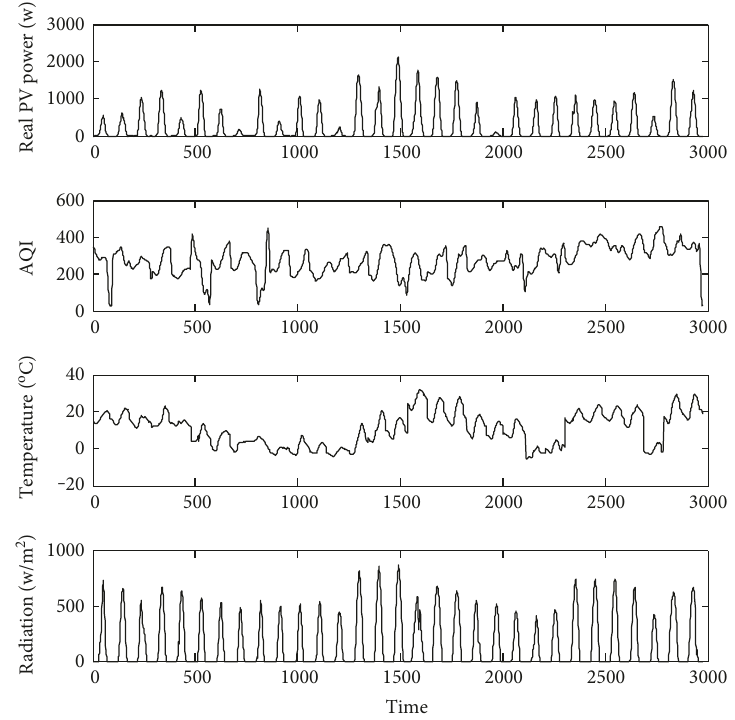
Figure 1: PV power and other meteorological parameters during haze weather.